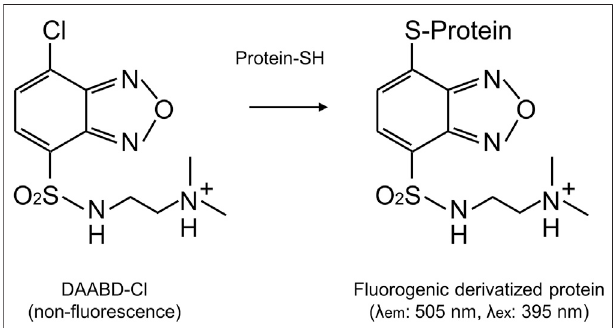
FIGURE 1 | Derivatization of proteins with the fl uorogenic reagent